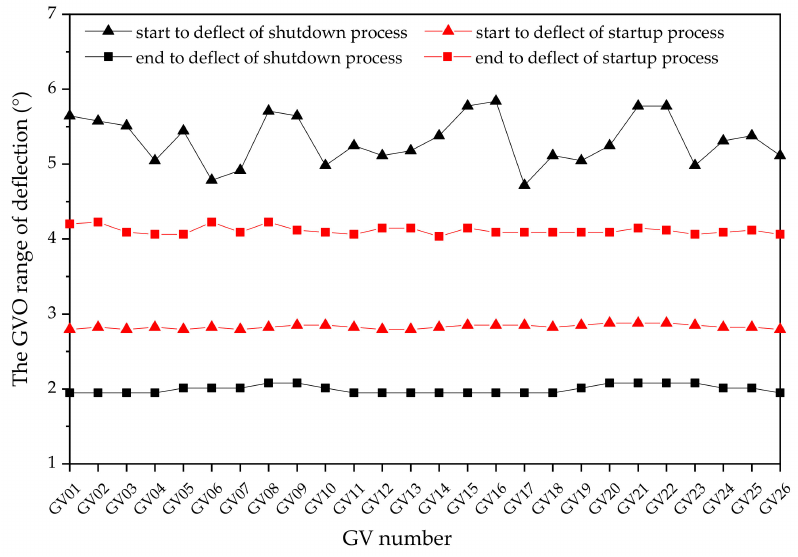
Figure 13. A comparison of GVO ranges of the deflections between the shutdown and startup